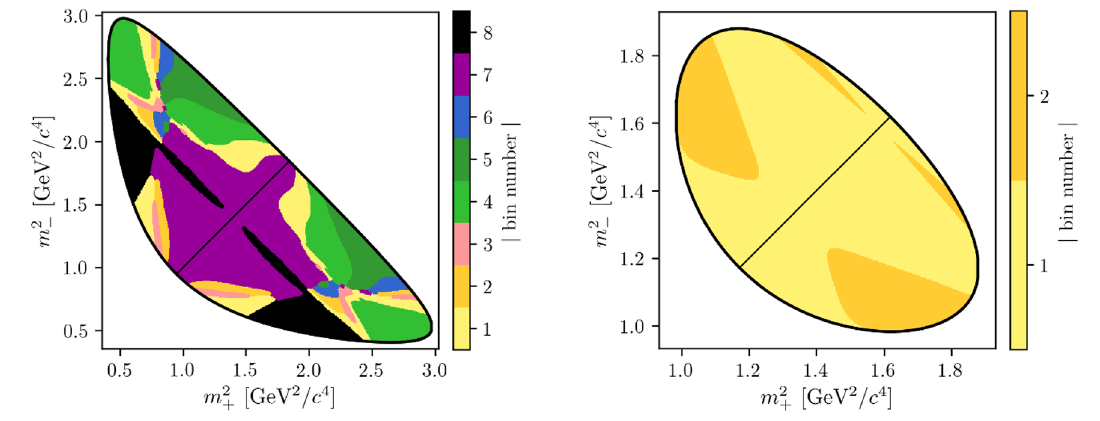
Figure 1 . Binning schemes for (left) D → K 0 The diagonal line separates the positive and negative bins, where the positive bins are in the region in which m 2 > m 2 is − +